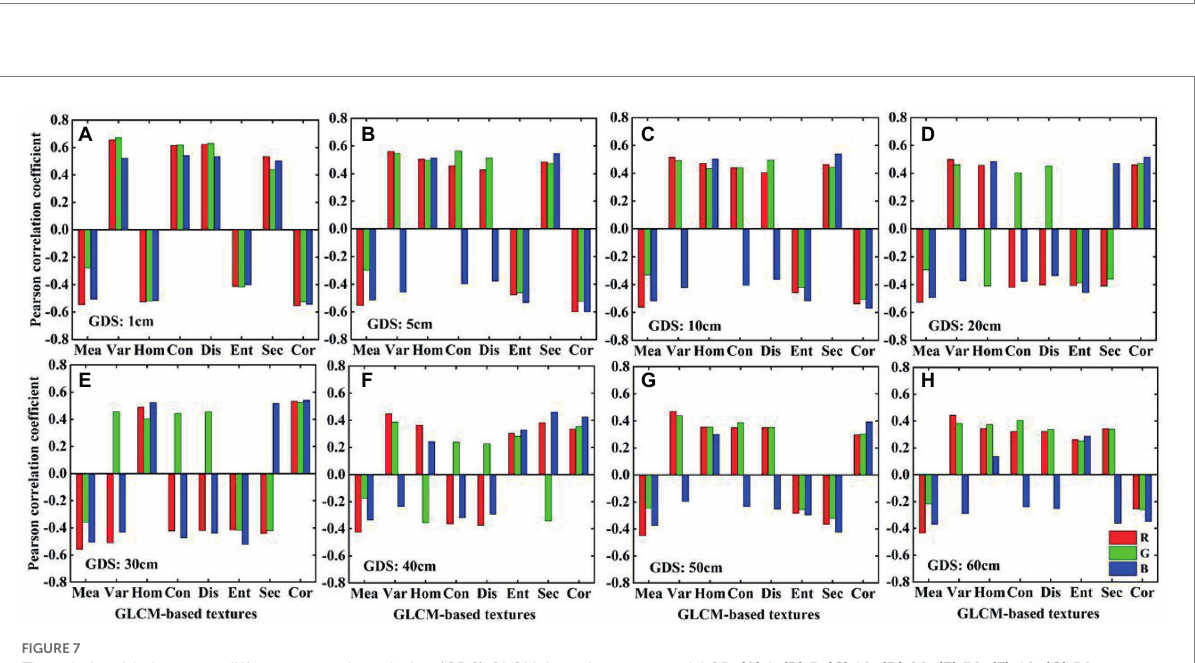
above-ground potato plants. A small number of leaves even fall off, which reduces the crop height and AGB simultaneously, as shown in plot s03 of Supplementary Figure 1.